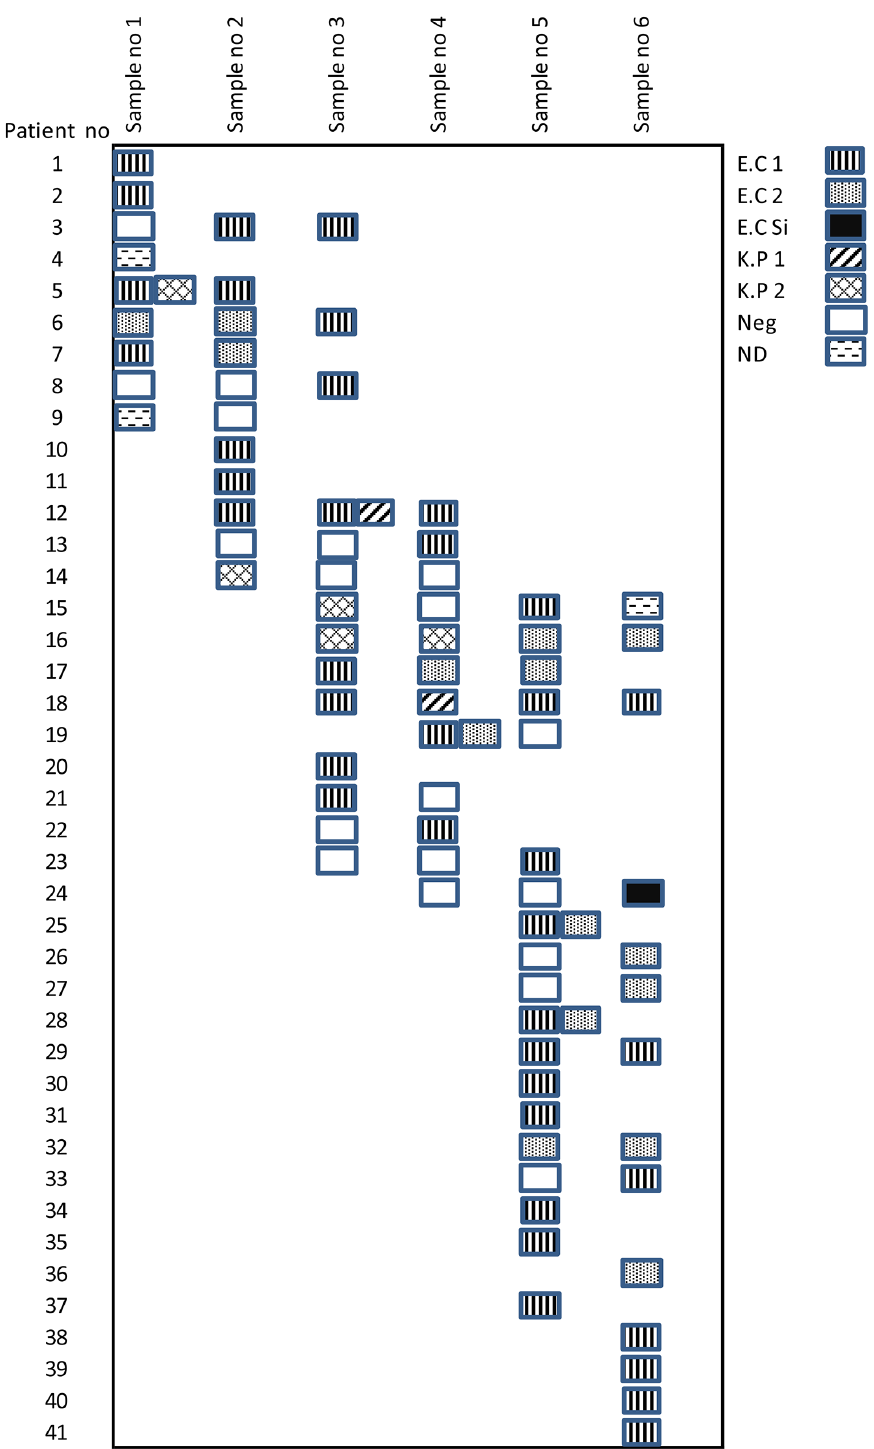
Figure 1. Different strain types of E.coli and K.pneumoniae isolated from various sampling occasions. E.C= E.Coli , K.P= K. Pneumoniae , ND=Verified ESBL, DL-typing not done. The ESBL-producing bacteria, found in our study, were resistant to the preferred first line antibiotic combination in Gram-negative sepsis (Table 2), which makes it probable that the empirical regimen for unknown bloodstream infection might be